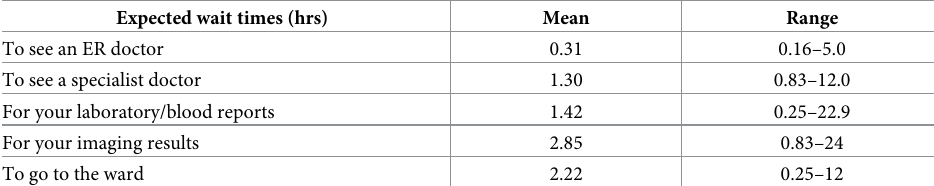
Table 8. Expected wait times.